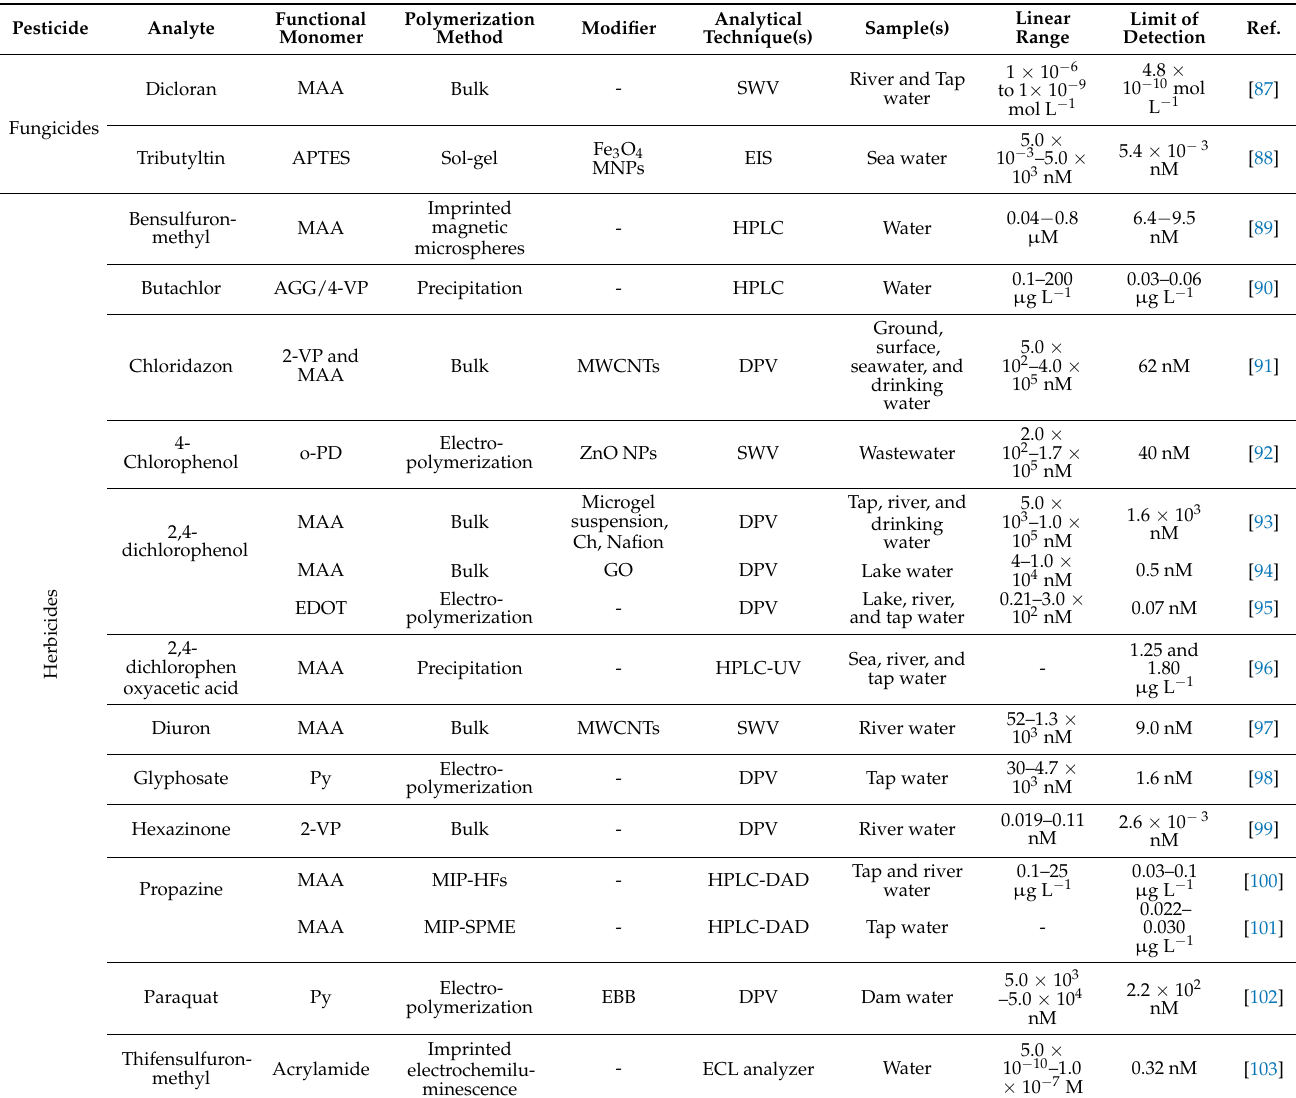
Table 3. Application of MIPs based on solid phase extraction and sensors for the detection of pesticides in water samples. Pesticide Analyte Functional Monomer Polymerization Method Modifier Analytical Technique(s) Sample(s) Linear Range Limit of Detection Ref.